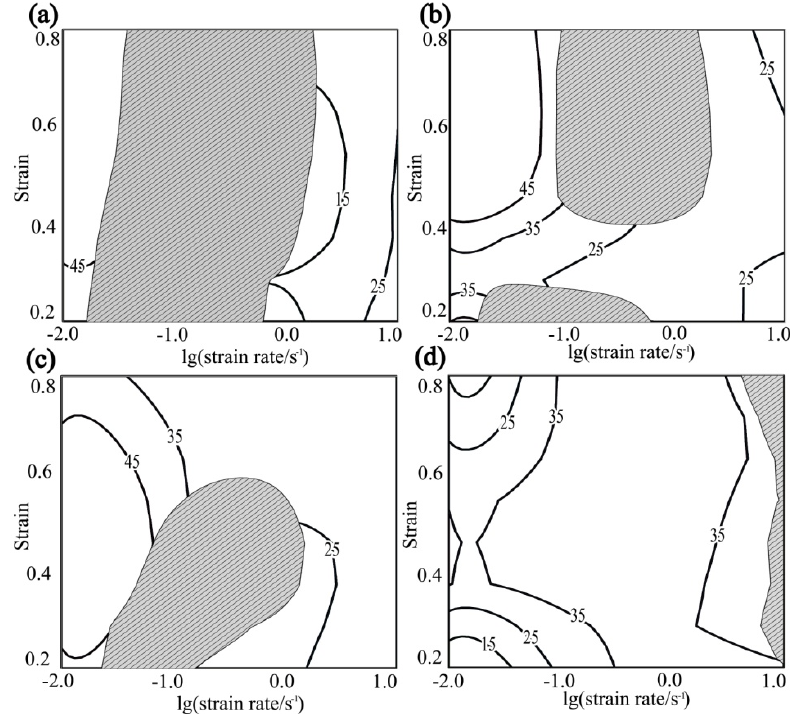
Figure 10. Hot working maps of 300M steel at the strain rate of ( a ) 0.01 s − 1 , ( b ) 0.1 s − 1 , ( c ) 1 s − 1 , and ( d ) 10 s − 1.